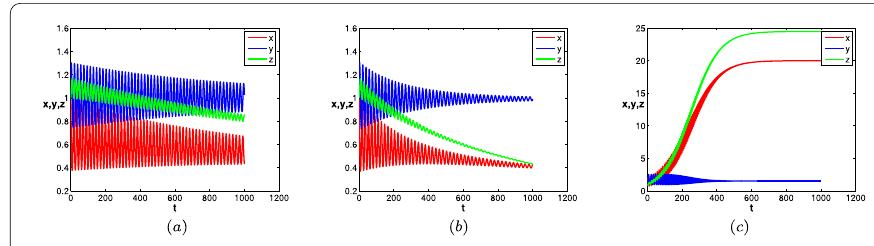
Figure 3 Phase diagram of Experiment 1 with the value of the parameter, for parameters see Table 2